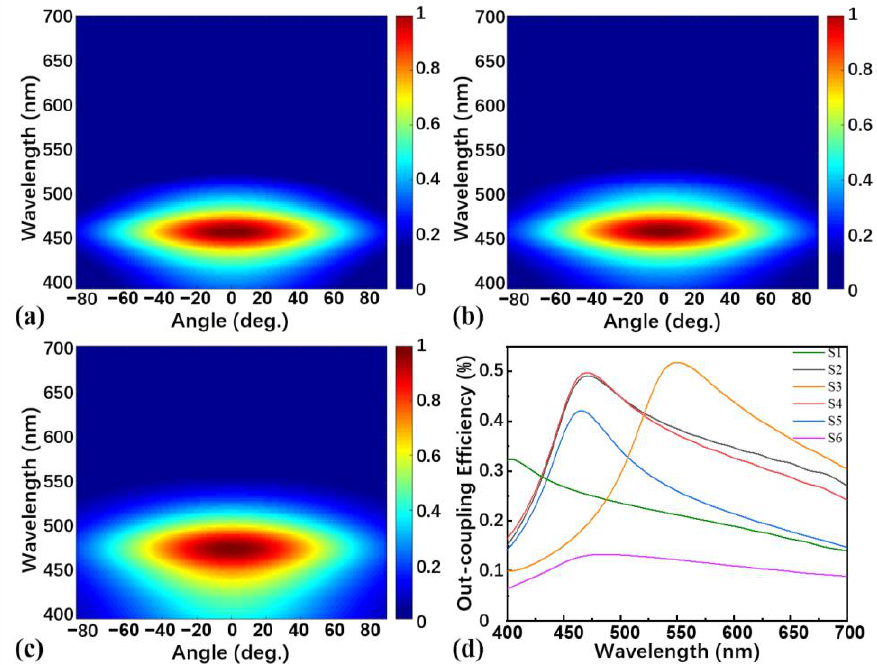
Figure 3. FDTD simulation of angle-wavelength-dependent normalized emission intensities of the device ( a ) S4, ( b ) S5, and ( c ) S6; ( d ) FDTD simulation of light out-coupling efficiency of all TOLED devices.